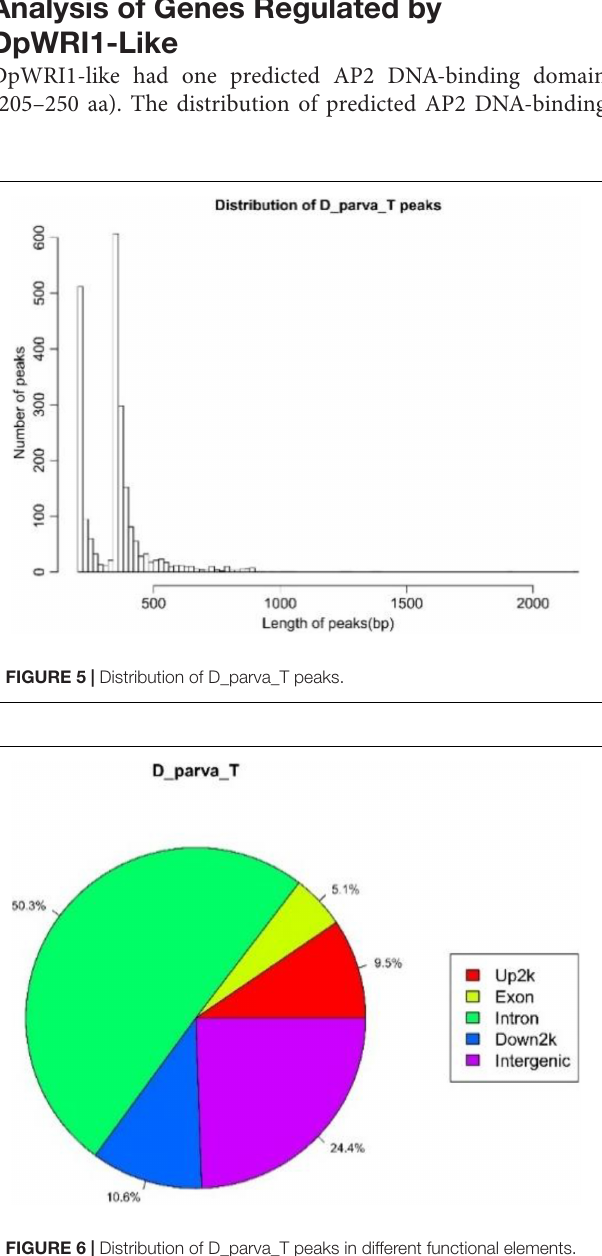
FIGURE 6 | Distribution of D_parva_T peaks in different functional elements. The Up2k indicated the upstream (2,000 bp) from transcription start site. The Down2k indicated the downstream (2,000 bp) from transcription start